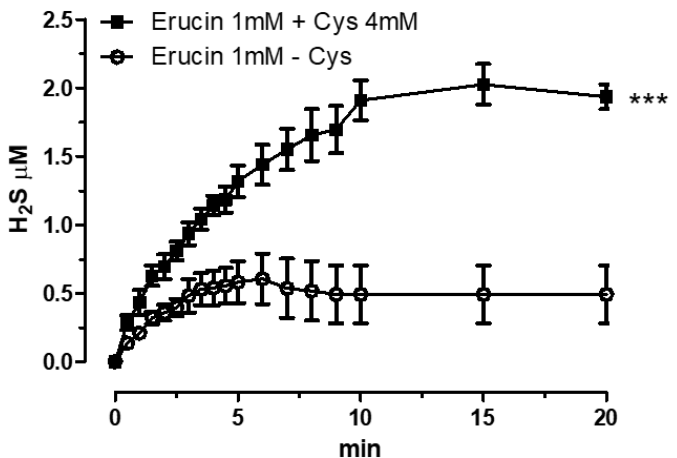
Figure 2. Amperometric recording of the H 2 S-releasing properties of erucin. The lines represent the increase in H 2 S during time (20 min) released by erucin in the presence and in the absence of L-Cysteine (Cys 4mM). Results are shown as mean ± SEM. *** p < 0.001 vs. H 2 S release in the absence of L-Cysteine.